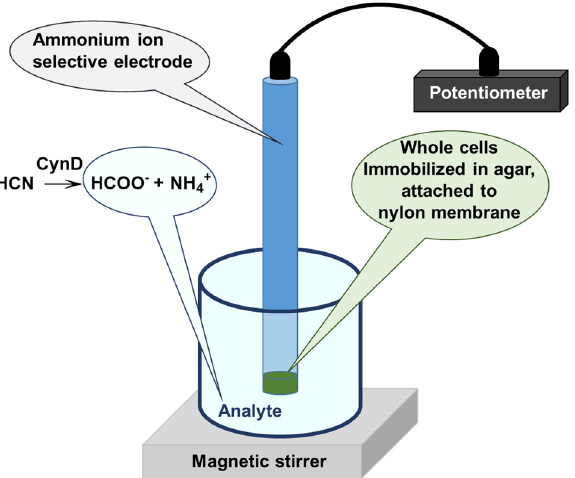
Figure 9. Potentiometric determination of free cyanide (fCN, depicted as HCN) using whole cells of Flavobacterium indicum with cyanide dihydratase (CynD) activity. The cells were entrapped in agar and the resulting catalyst was adsorbed on a nylon membrane. The sensor was used to determine fCN concentrations between 1.5 × 10 − 9 and 2.5 × 10 − 3 M [63]. The CynH from A. niger was used in the form of a whole-cell catalyst held in place by a semipermeable cellulose membrane. The reaction was carried out in a bench-scale flow reactor fed with a solution of 25 mM KCN. The conversion was maintained above 80% for 3 days [32].